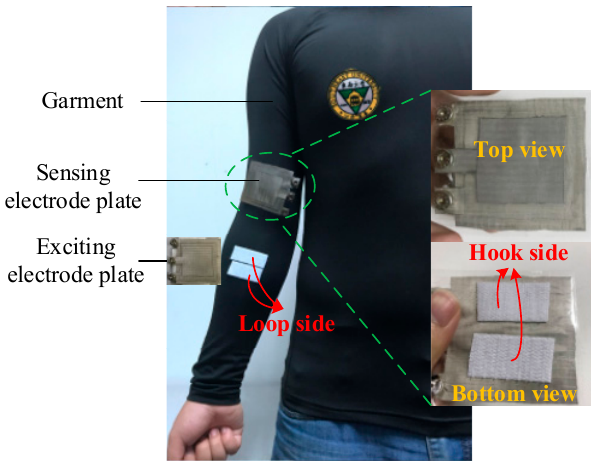
Figure 5. A garment with hook-and-loop fasteners used to fix the NFCAS.